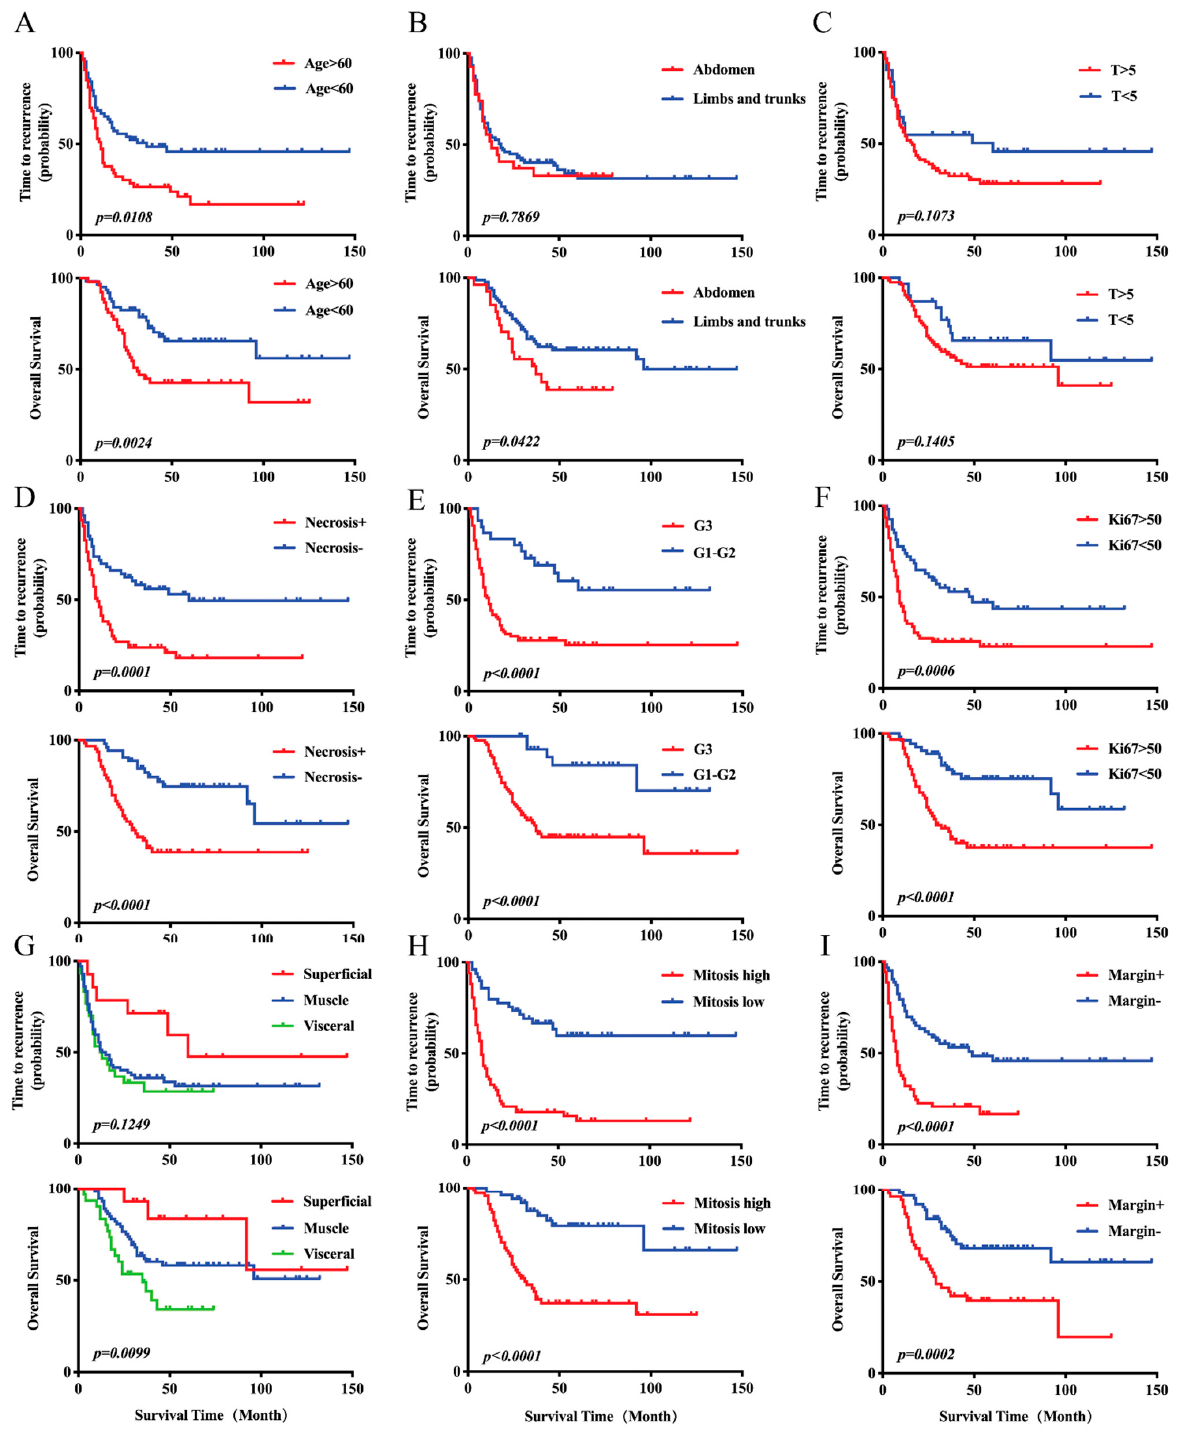
Figure 2. Prognostic significance of clinicopathological factors in UPS patients ( n = 116). ( A ) Kaplan–Meier analysis of time to recurrence (TTR) (upper) and overall survival (OS) (bottom) according to age. ( B ) Kaplan–Meier analysis of TTR (upper) and OS (bottom) according to tumor site. ( C ) Kaplan–Meier analysis of TTR (upper) and OS (bottom) according to tumor size (cm). ( D ) Kaplan–Meier analysis of TTR (upper) and OS (bottom) according to necrosis. ( E ) Kaplan–Meier analysis of TTR (upper) and OS (bottom) according to French Federation Nationale des Centres de Lutte Contre le Cancer (FNCLCC) grade. ( F ) Kaplan–Meier analysis of TTR (upper) and OS (bottom) according to Ki-67. ( G ) Kaplan–Meier analysis of TTR (upper) and OS (bottom) according to invasive depth. ( H ) Kaplan–Meier analysis of TTR (upper) and OS (bottom) according to mitosis. ( I ) Kaplan–Meier analysis of TTR (upper) and OS (bottom) according to surgical margin.